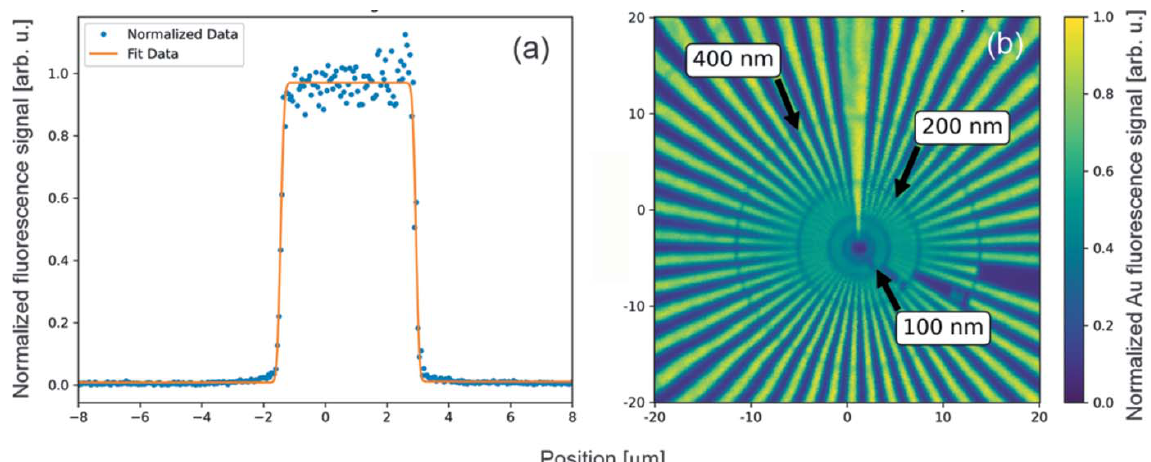
Figure 7 Initial X-ray commissioning results performed at the SRX beamline. The measurements were taken at 12 keV photon energy; the secondary source aperture has been closed down to 10 m m. Panel ( a ) demonstrates a horizontal line scan across a well defined line feature on the Siemen test pattern. The initial FWHM resolution obtained during the measurements is (cid:2) 188 nm during a scan with a 50 nm step-size, 20 ms dwell time and 16 m m travel range. Panel ( b ) depicts a 2D scan across a Siemens star test pattern. Sub-200 nm features in the horizontal direction are clearly visible. Scan parameters: 20 m m (cid:5) 20 m m scan area, 50 nm step size, and 50 ms dwell time. The overall duration of the scan was (cid:2) 3